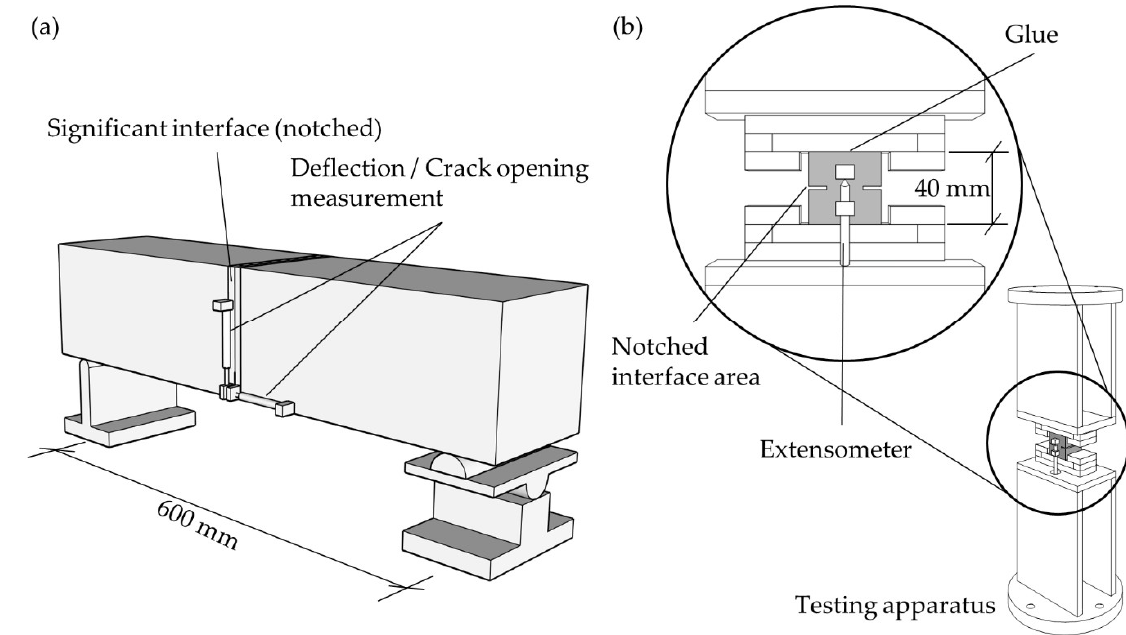
Figure 6. ( a ) Three-point bending test setup for specimen with 150 mm edge length and 700 mm length and ( b ) Uniaxial tensile test setup.